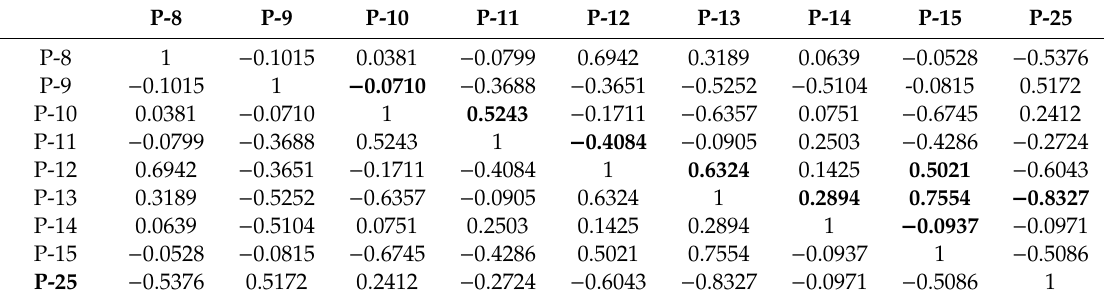
Table 4. Correlation between micromalting indicators and limit of attenuation (LAT) for the test wheat (Pearson correlation